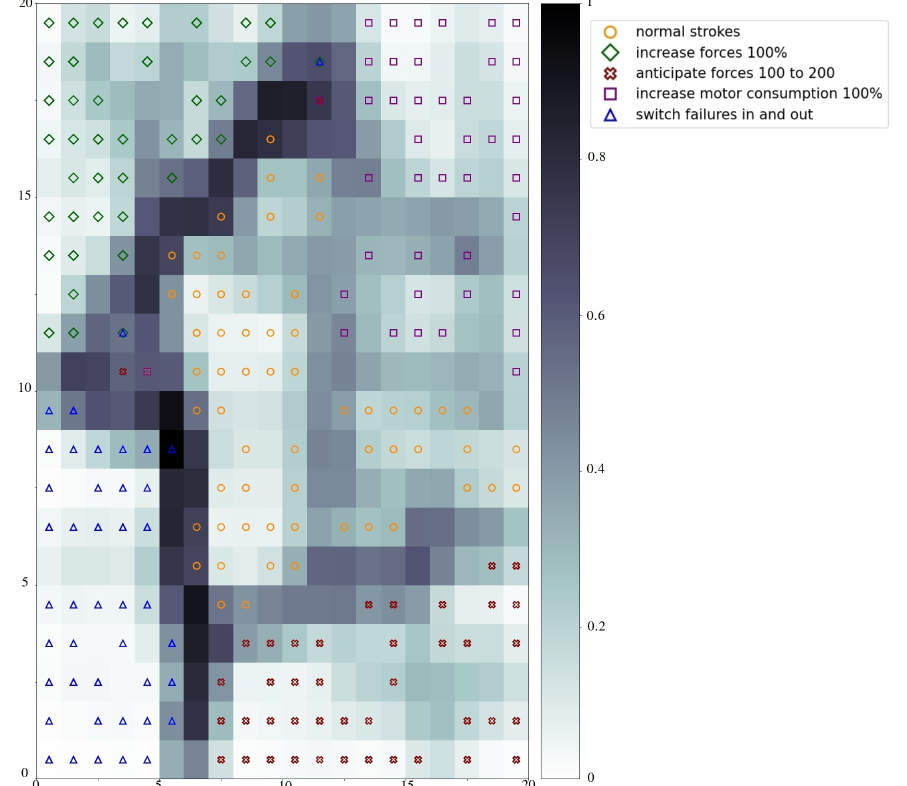
Figure 6. SOM of correct data and main failure types, represented by different forms and colors in a 20 × 20